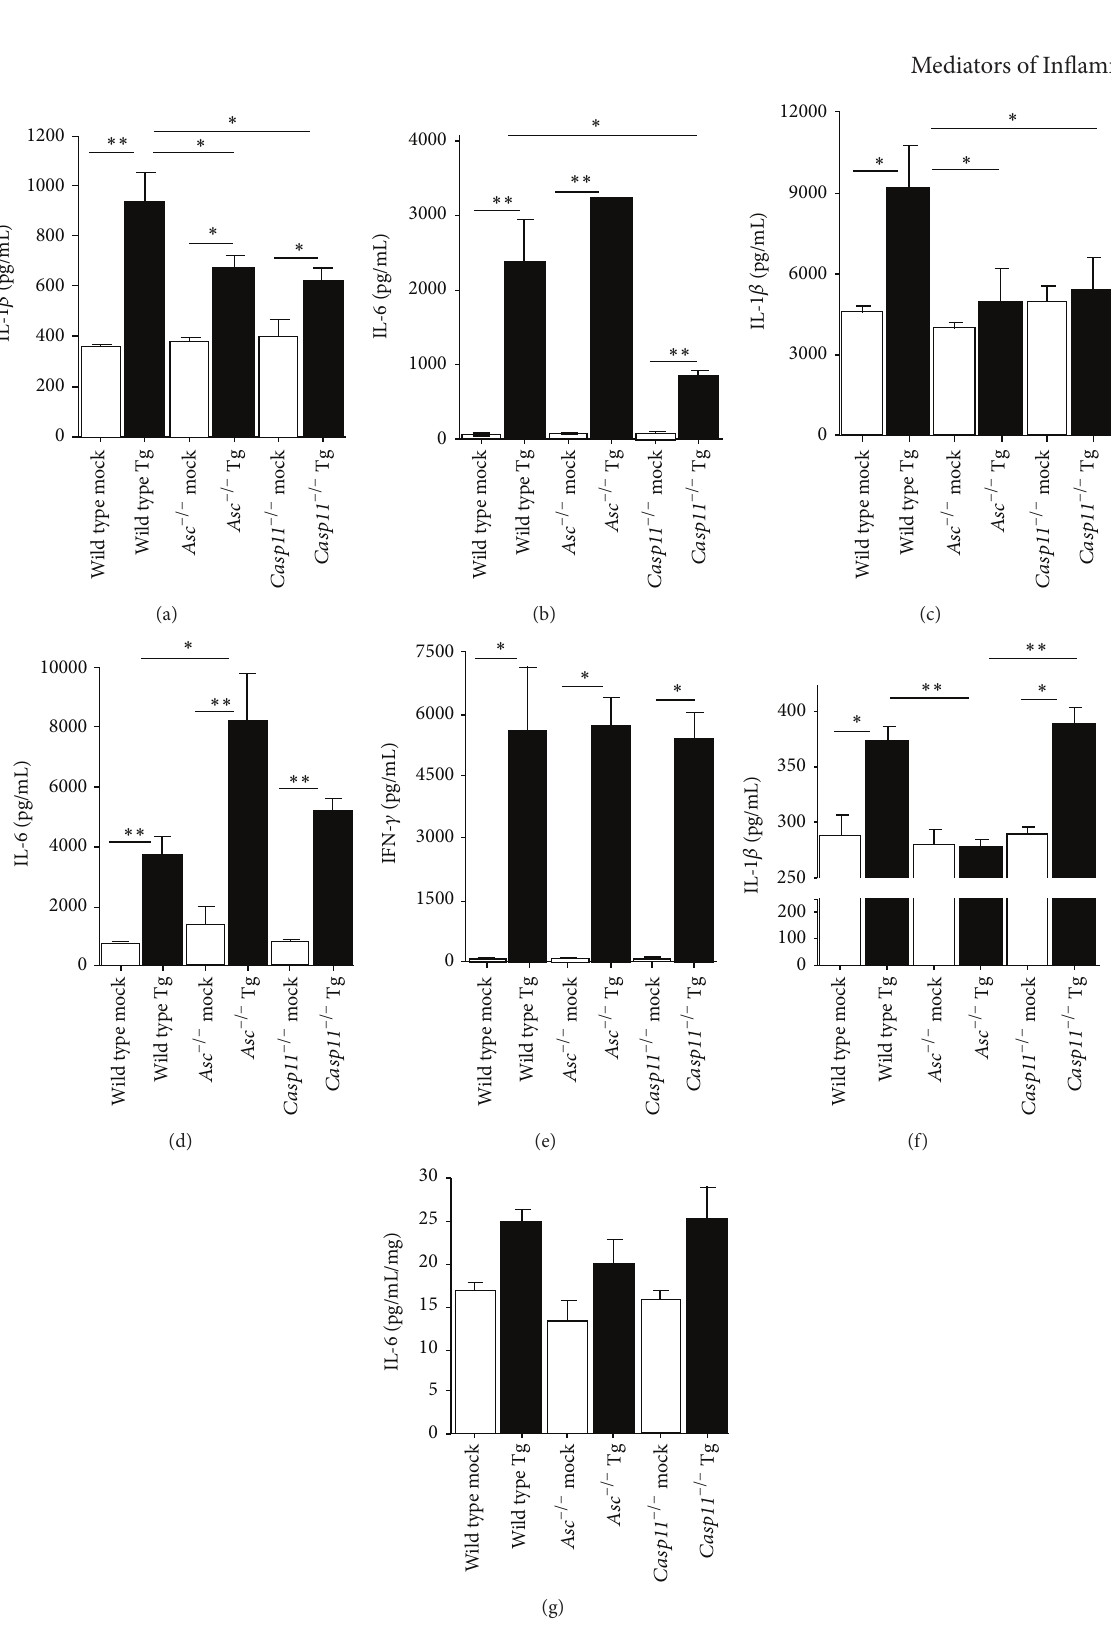
Figure 5: Local and systemic levels of IL-1 𝛽 and IL-6 were significantly attenuated in Casp11 −/− mice following infection with Toxoplasma gondii . Whole blood, peritoneal lavage fluid (PLF), and brains were collected from wild type, Casp11 −/− , and Asc −/− mice 15 days after inoculation with Toxoplasma gondii Me49 (a–d). IL-1 𝛽 and IL-6 levels were determined in (a, b) serum and (c, d) cell-free PLF supernatant by ELISA. (e) IFN- 𝛾 levels were also evaluated in the cell-free PLF supernatant. (f, g) Brain samples were weighed and homogenized, and IL-1 𝛽 and IL-6 levels were determined using the resultant cell-free supernatants. ∗ 𝑝 < 0.05 ; ∗∗ 𝑝 < 0.01 . Wild type mock, 𝑛 = 9 ; Asc −/− mock, 𝑛 = 9 ; Casp11 −/− mock, 𝑛 = 6 ; wild type Tg, 𝑛 = 18 ; Asc −/− Tg, 𝑛 = 18 ; Casp11 −/− Tg, 𝑛 = 13 . Data shown are representative of 3 independent